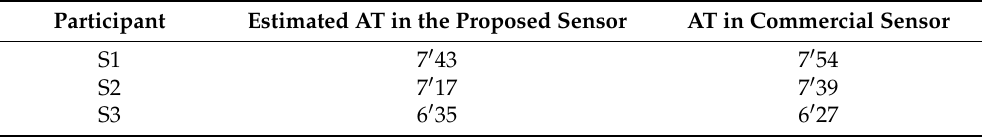
Table 1. Comparison of the timings of the AT obtained using the proposed sensor and a commercial sensor for the three